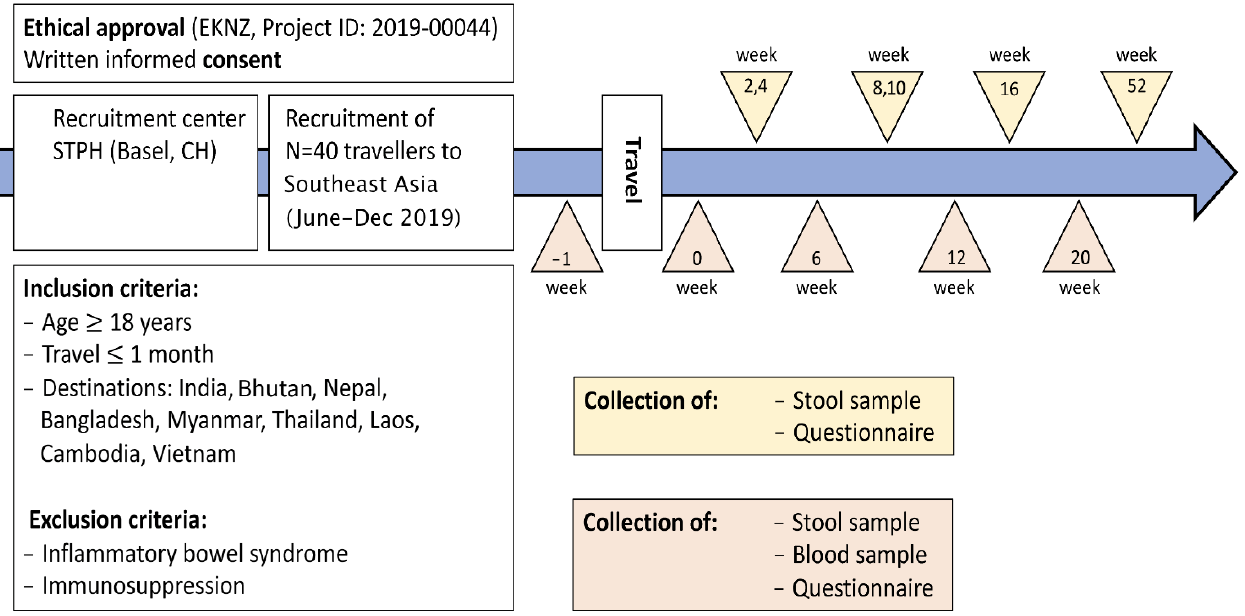
Figure 1. Study flow for patient recruitment and sample collection (see Supplementary File 5).